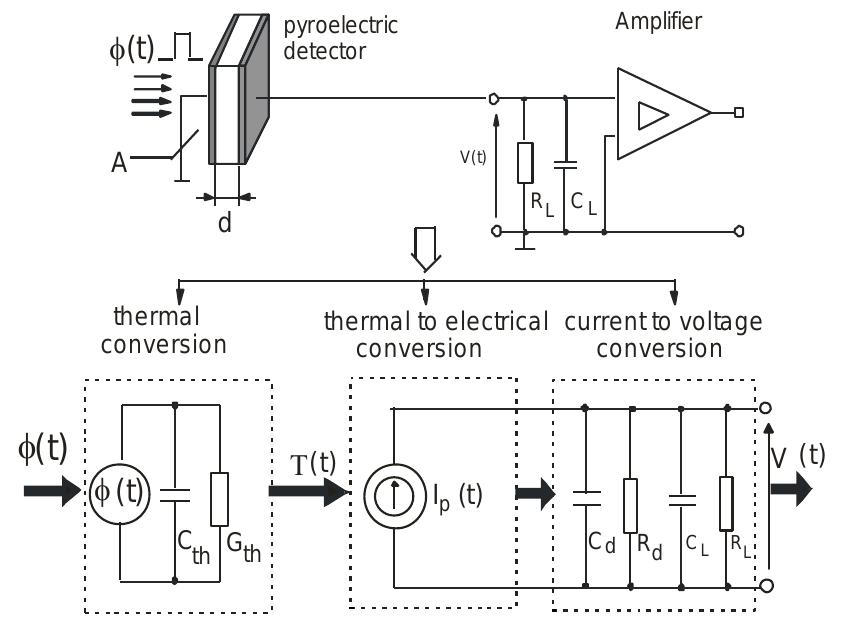
Figure 1. Thermal and electrical equivalent circuit of pyroelectric detector cooperating with amplifier.